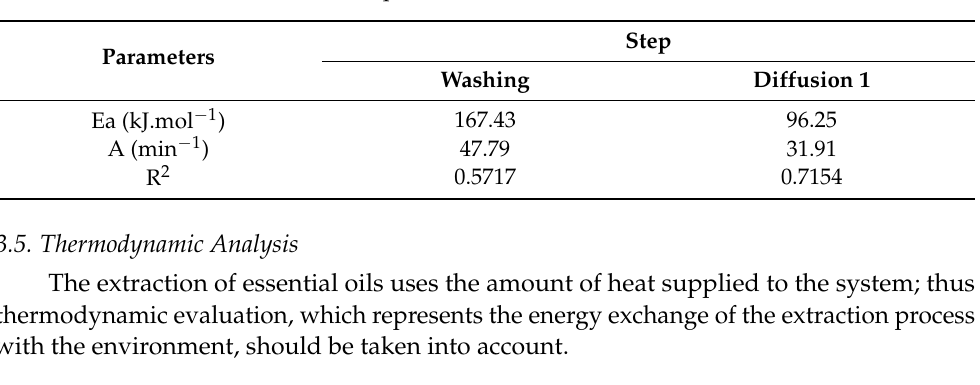
Table 6. Parameters of the Arrhenius